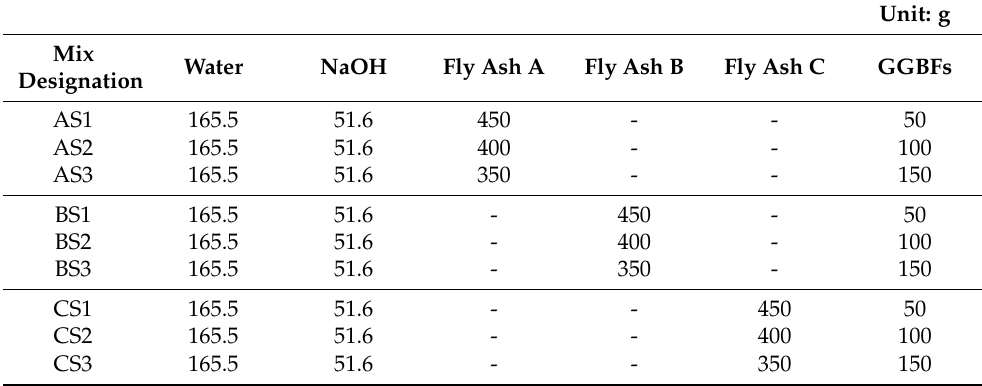
Table 2. Example of proportion at AE% = 8%.